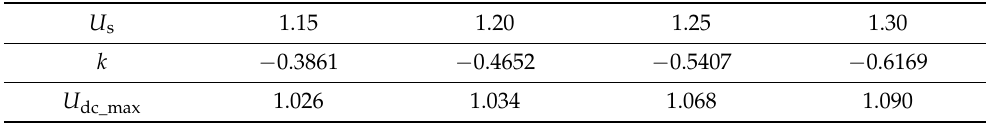
Table 4. Results for optimal k values and DC bus voltages for different voltage